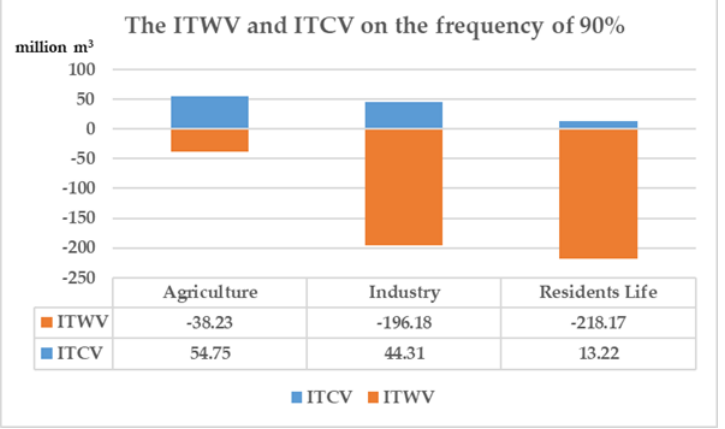
Figure 6. The ITWV and ITCV of industry on the frequency of 90%. (ITWV is short for tradable water volumes of industry. ITCV is short for tradable control volumes of industry.).